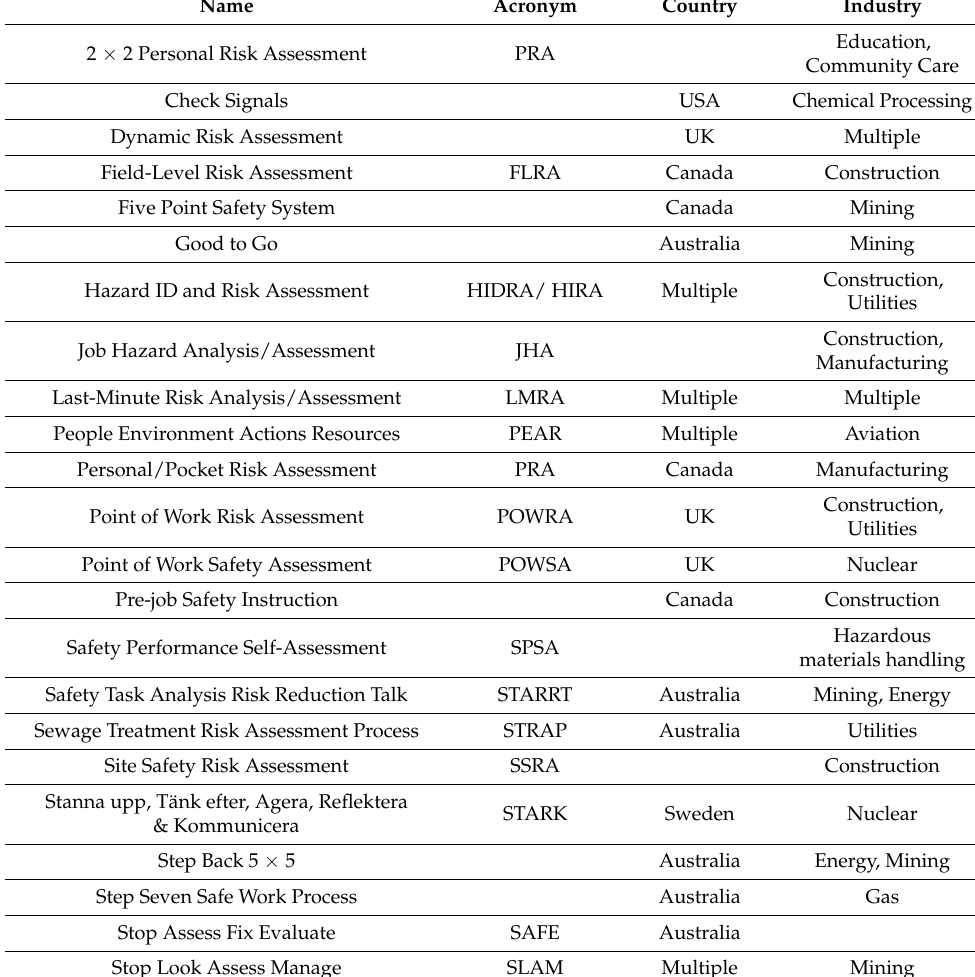
Table 1. Alternative names for Take